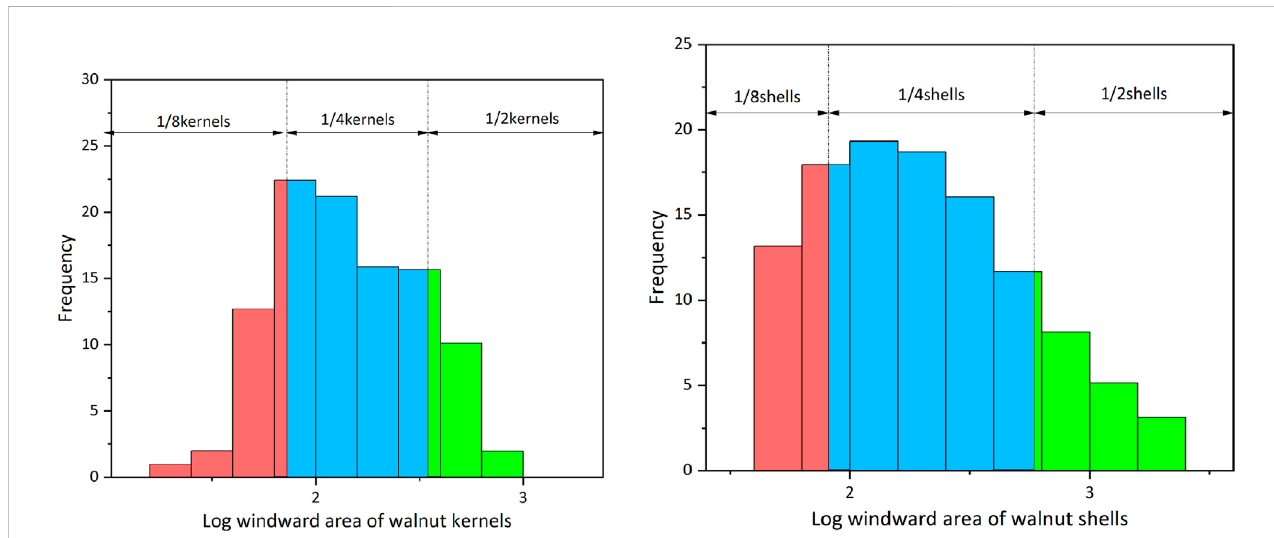
FIGURE 3 Walnutwindwardareadistributeddiagramofnumericalfrequency. (A) Frequencydistributionofwalnutkernelsontheleftand (B) Frequencydistribution of walnut shells on the